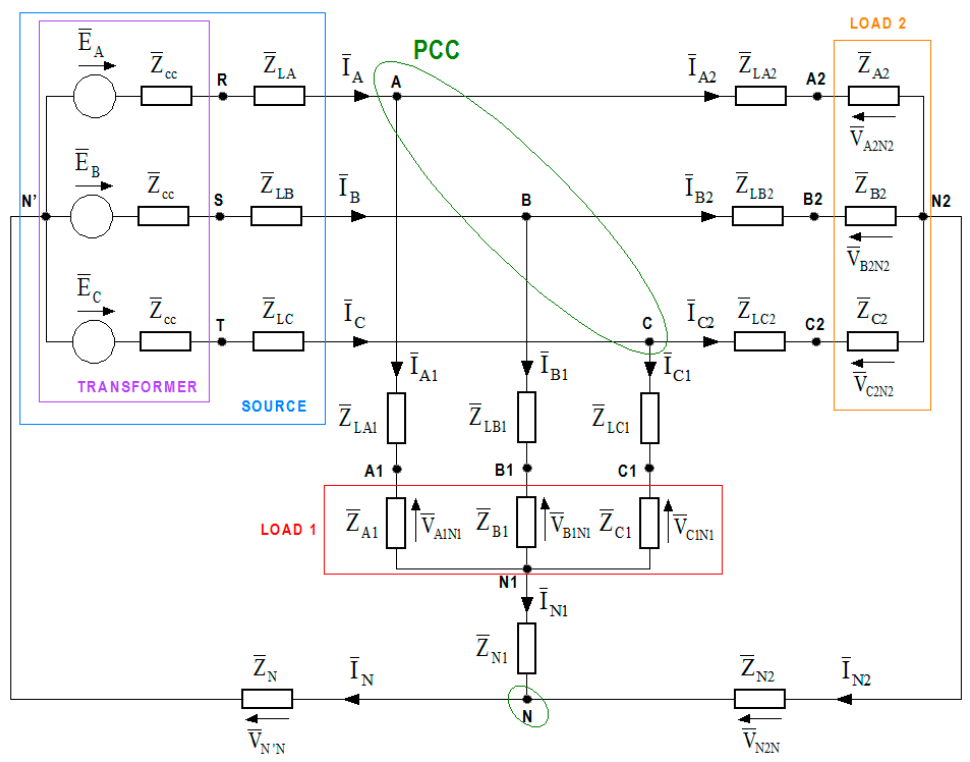
Figure 1. Schematic representation of the three-phase system and its different subsystems.